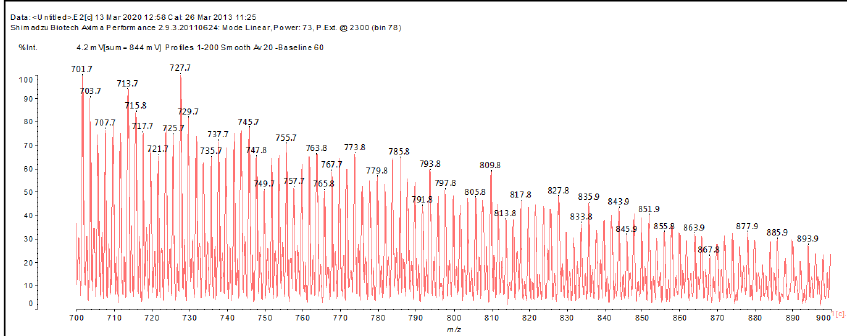
Figure 6. MALDI ToF spectrum of humins obtained at 180 °C from fructose, 500 – 1500 Da range.